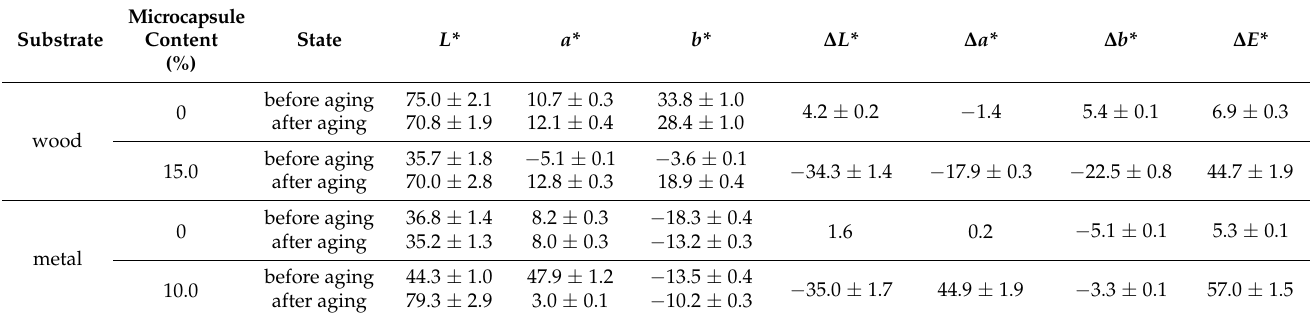
Table 13. Color difference data of the coatings before and after